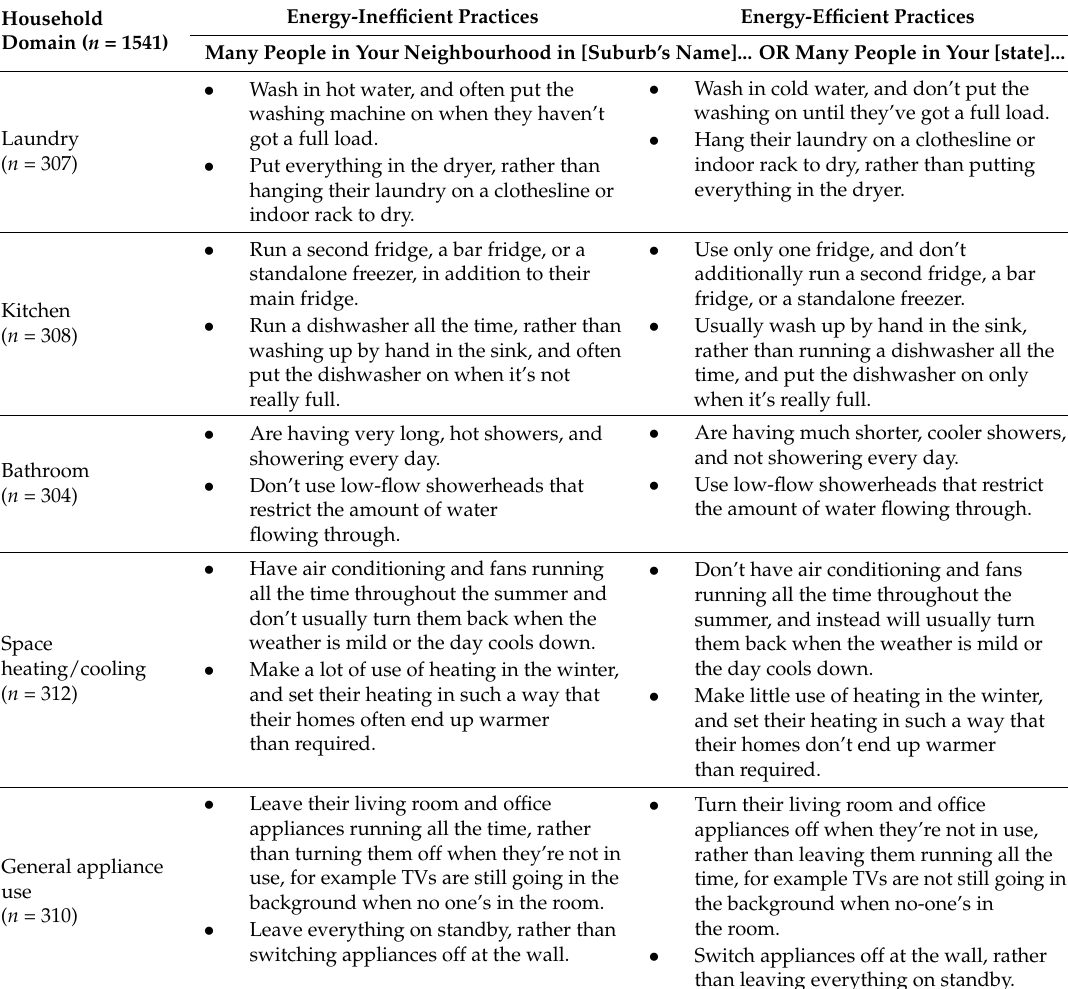
Table 6. Energy usage practices described in the course of eliciting responses in each household domain. Household Domain ( n =